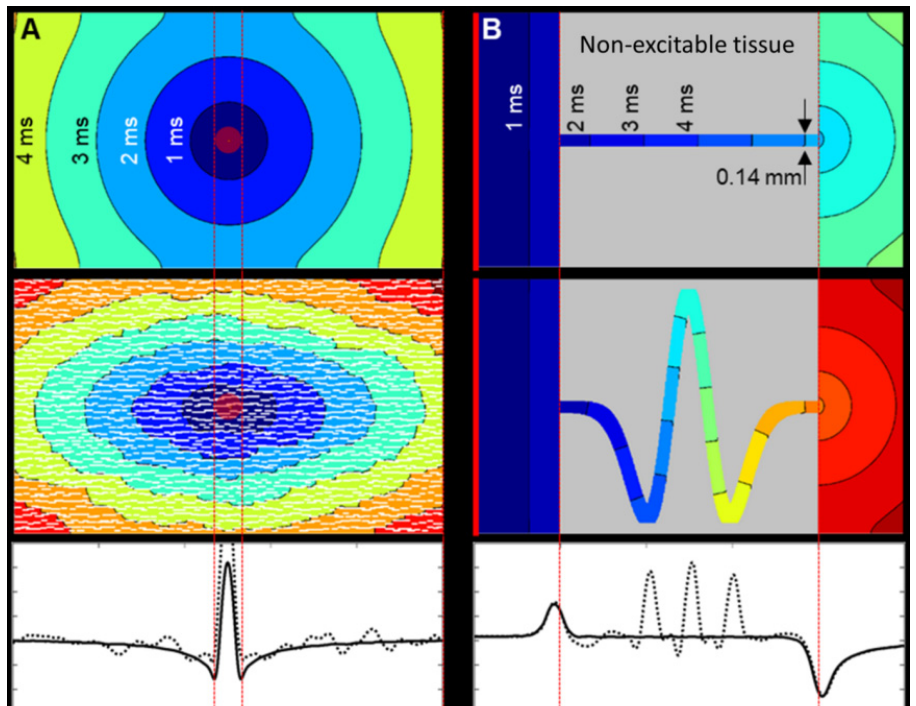
Figure 5. Geometric factors affecting source-sink loading and its effect on CV. Isochrones are separated by 1 ms. ( A ) Focal electrical activation (red central disk), simulated in a simple rectangular 2D tissue model with common membrane dynamics and isotropic electrical conductivity (see Appendix A). (Top) Isotropic tissue. Single vector longitudinal CV is 0.54 m/s and transverse CV is 0.56 m/s. (Middle) Tissue with explicit non-conducting cleft space between layers of cells causes naturally anisotropic activation spread, with a longitudinal single vector CV of 0.57 m/s and reduced transverse CV of 0.28 m/s (i.e., ratio of about 2:1 [76]). (Bottom) Multi-vector CV along the central axis shows the similarity between the isotropic (solid) and discontinuous (dotted) domain CVs. CV is the lowest at the edges of the central stimulus site, as the curvature of the activation wavefront is greatest. ( B ) Planar electrical activation (starting at the left-hand edge: red line) in a simple tissue model of constriction and expansion with Luo–Rudy membrane dynamics and isotropic electrical conductivity. (Top) Simple tissue tract, crossing non-excitable tissue. CV increases upon entering and decreases upon exiting the constriction as a result of step-changes in the source-sink ratio. Single vector (left to right) CV across the whole model is 0.5 m/s, and within the constriction itself, it is 0.61 m/s. (Middle) Tortuous tissue tracts add additional distance to the paths, and local CV is perturbed from a straight path scenario. The apparent single vector CV across the whole model is 0.26 m/s, and across the tract itself, it is 0.65 m/s. (Bottom) While the multi-vector CV before constriction and after constriction in the tortuous model (dotted line) is similar to the straight tract (solid line), local CV along the curved path is regionally increased as the tight bends locally to serve as a ‘shortcut’ (non-consecutive activation of all path elements). In spite of this, activation of the downstream wide tissue segment is delayed, because of increased path length, reducing apparent overall CV.